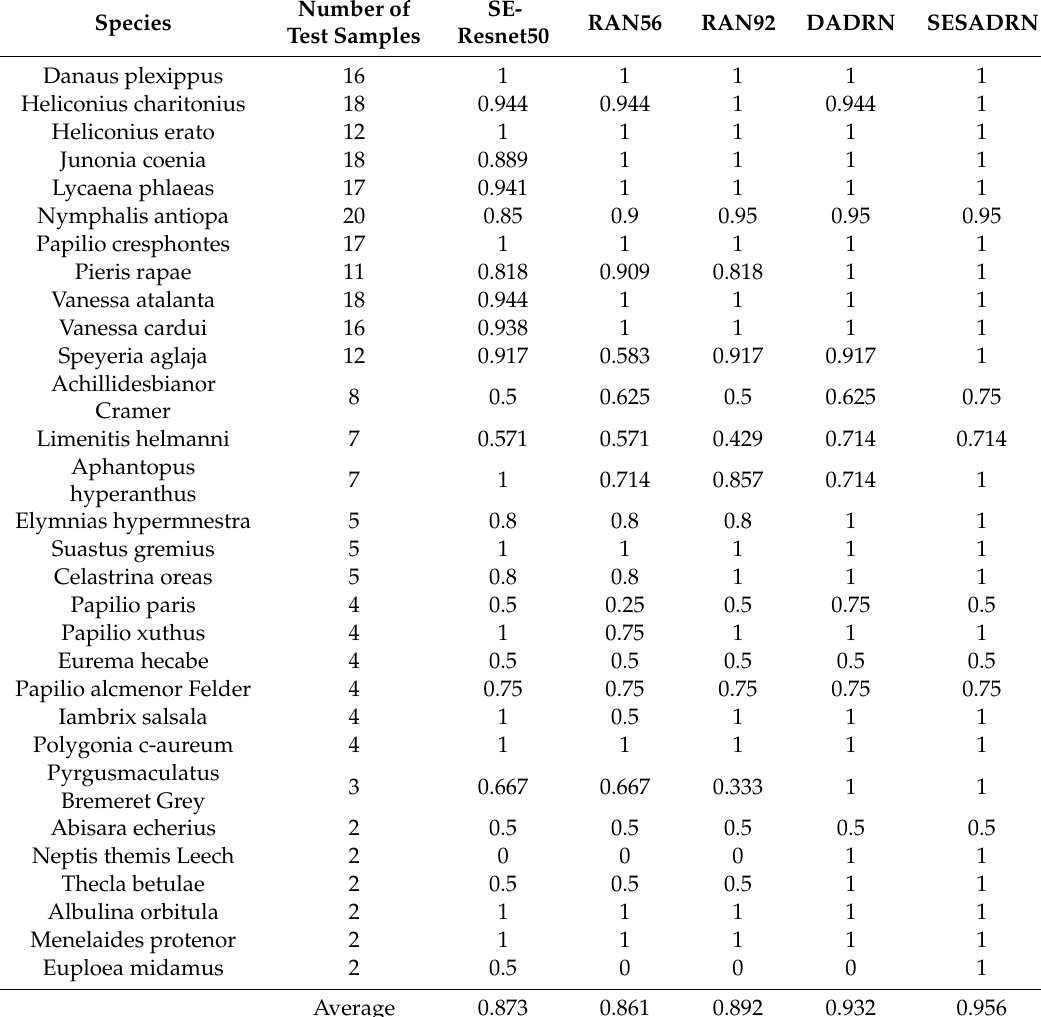
Table 3. Comparison of class-wise classification